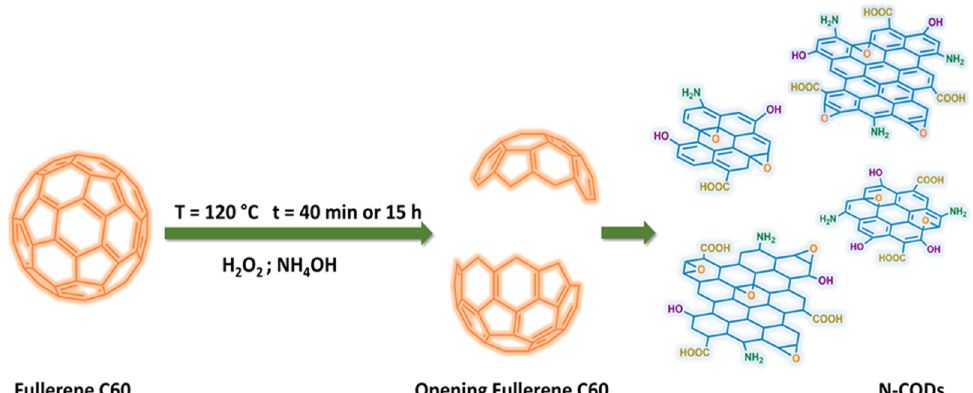
Figure 1. Preparation of fluorescent N-CQDs through hydroxyl radical-induced decomposition of fullerene C60.